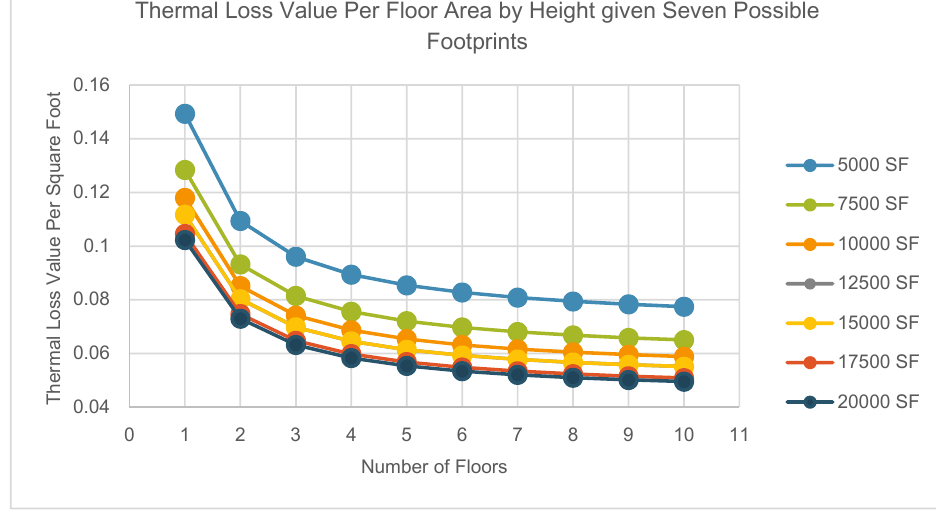
Figure 10. Thermal Loss Value per Unit Floor Area given a Static Footprint and Variable Total Building Area.